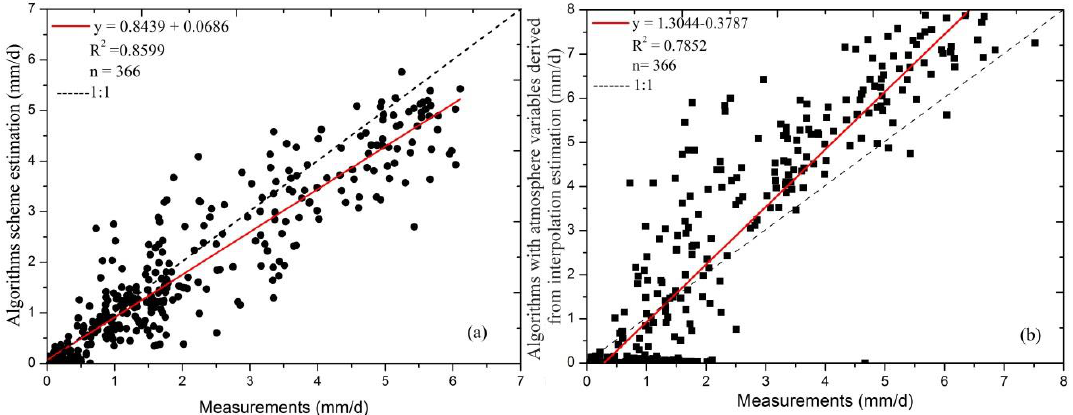
Figure 4. Observed and estimated daily ET in 2008 at the Yingke station from the proposed algorithms with atmospheric variables derived from ( a ) satellite data and ( b ) interpolation of meteorological measurements. Remote Sens. 2019 , 11 , x FOR PEER REVIEW